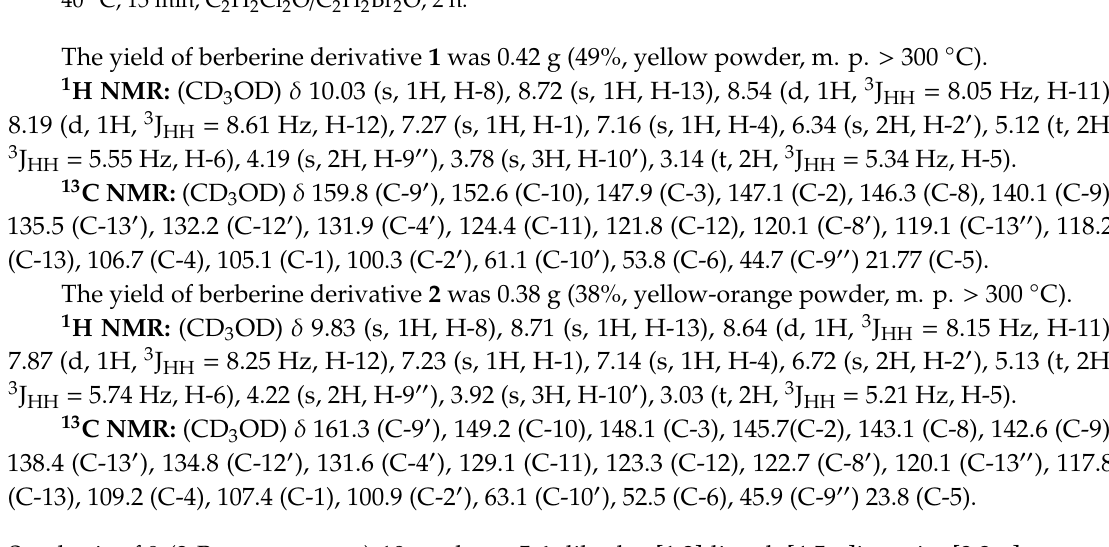
Berberrubine Scheme 1. Synthesis of berberrubine. Reaction conditions: (i) 195 °C (temperature of oil bath), 40 min. The yield of berberrubine was 1.25 g (62.5%, red-brownish powder, m. p.: 275–279 °C).